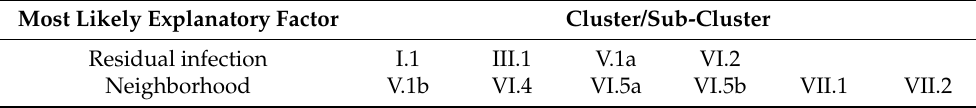
Table 4. Summary of explanatory factors for the epidemiological associations found by the identifica- tion of putative transmission clusters based on a maximum distance of 12 SNPs between M. bovis isolates obtained in Catalonia, Spain, from 2008 to